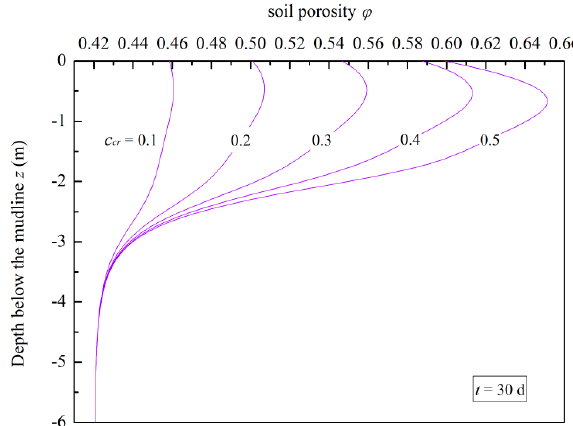
Figure 16. Variations of the soil porosity for different critical concentrations of the fluidized soil particles.